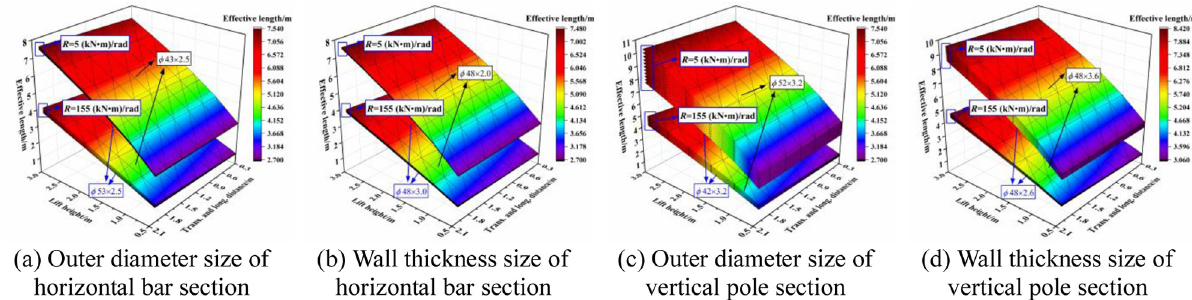
Fig 26. Three-dimensional diagrams of the influence of section size on the effective length. (a) Outer diameter size of horizontal bar section. (b) Wall thickness size of horizontal bar section. (c) Outer diameter size of vertical pole section. (d) Wall thickness size of vertical pole section.